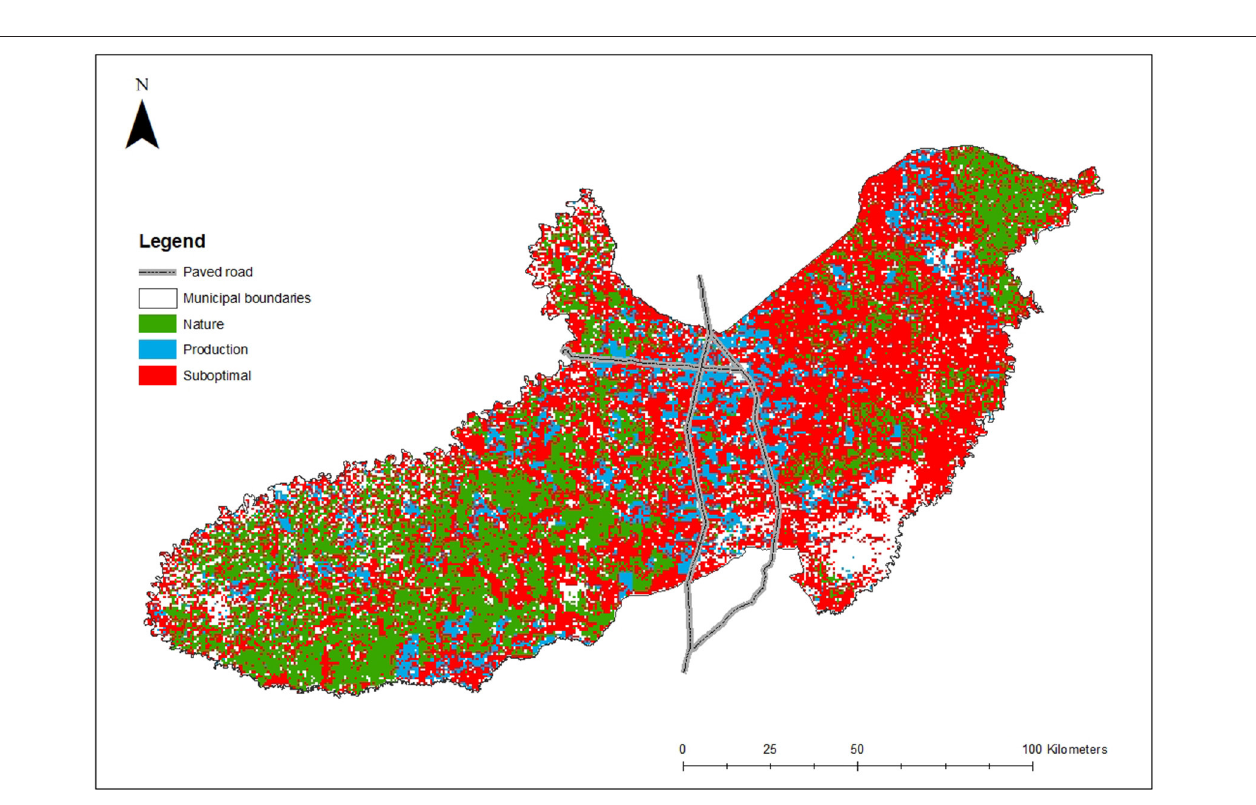
Frontiers in Environmental Science |